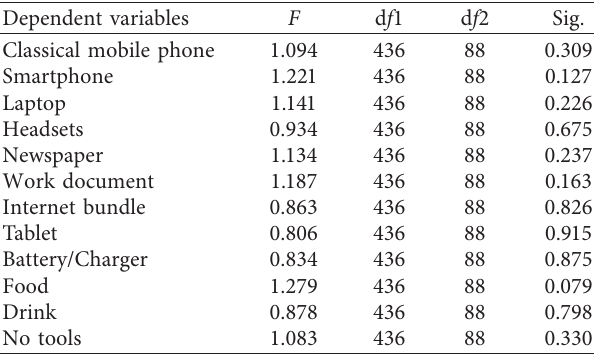
Table 10: Levene’s test of equality of error variances of the tools carried by travelers a